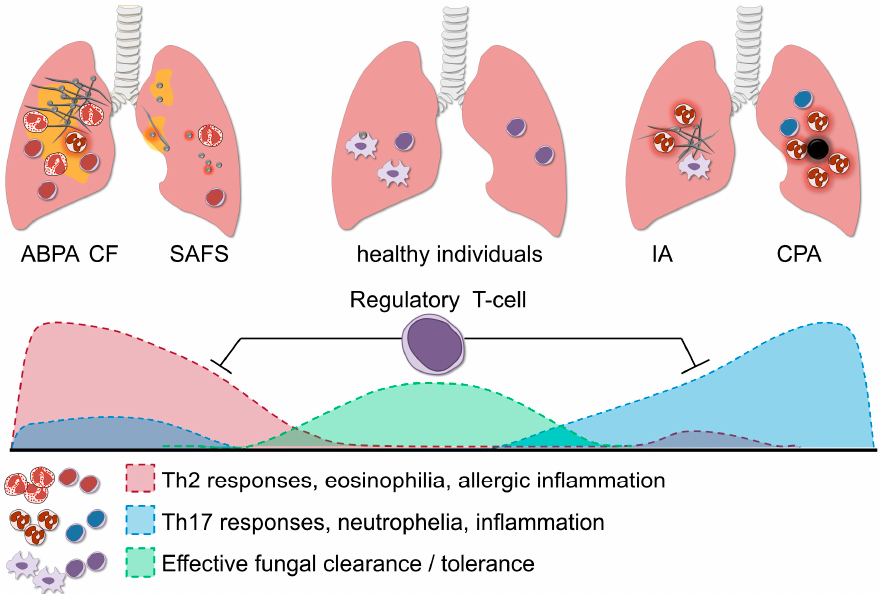
Figure 3. The role of regulatory T-cells in aspergillosis. Regulatory T-cells (Treg) orchestrate the balance of the Th1, Th2 and Th17 response; and this fine-tuning is necessary for effective fungal clearance in the host. In healthy individuals, the protective Th1 response effectively aids the clearance of A. fumigatus , whereas potential damaging excessive Th17 activation is dampened by Treg. A predominant Th2 response in allergic forms of aspergillosis such as SAFS and ABPA, leads to persistent inflammation and fungal colonization. In immunocompromised individuals, failure of innate immune cells to eliminate fungi may cause invasive aspergillosis (IA). When the Th17 response is too potently induced this might lead to excessive neutrophil influx and collateral damage. Fine-tuning of the strong pro-inflammatory responses during aspergillosis is facilitated by Treg, which in turn suppress the Th17/Th2 activity and prevent damage to the